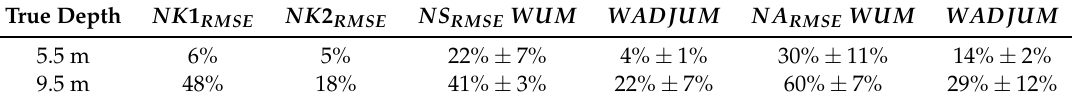
Performance of WUM and WADJUM when a random error with an uniform law U [ − 0.5,0.5 ] m is added to the seabed depth, for a true seabed depth of 5.5 m and of 9.5 m, in the case of moderately turbid